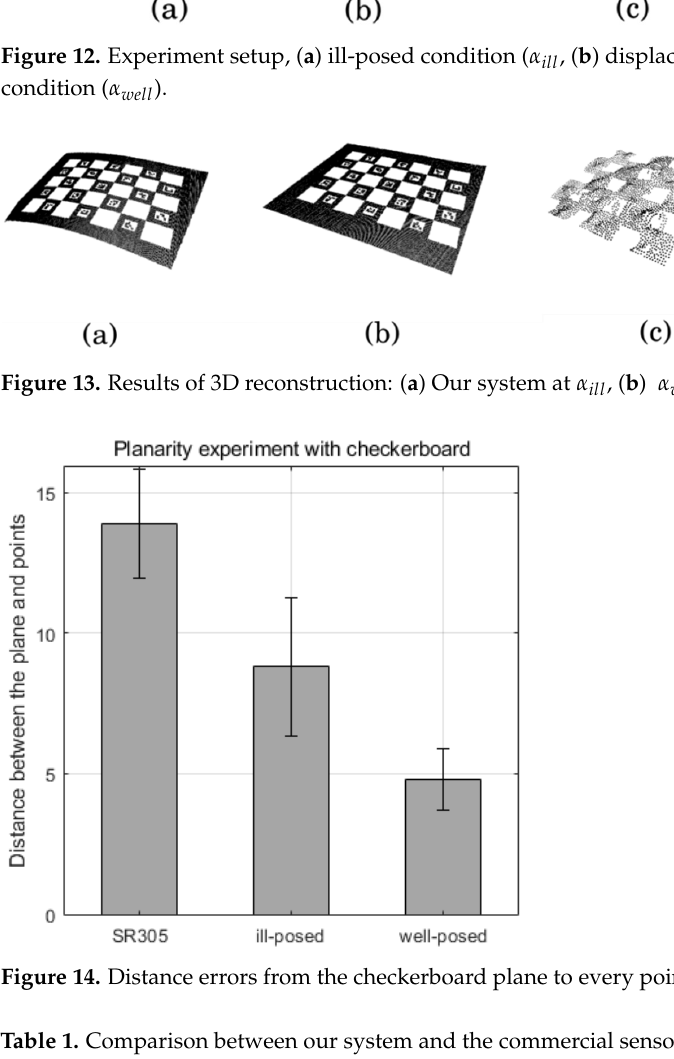
Figure 12. Experiment setup, ( a ) ill-posed condition (   ), ( b ) displacement part, and ( c ) well-posed condition (   ). Table 1. Comparison between our system and the commercial sensor (SR305).